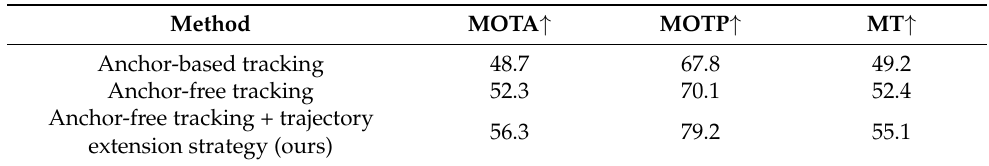
Table 4. The results of ablation experiments of different models of our algorithm on the MOT16